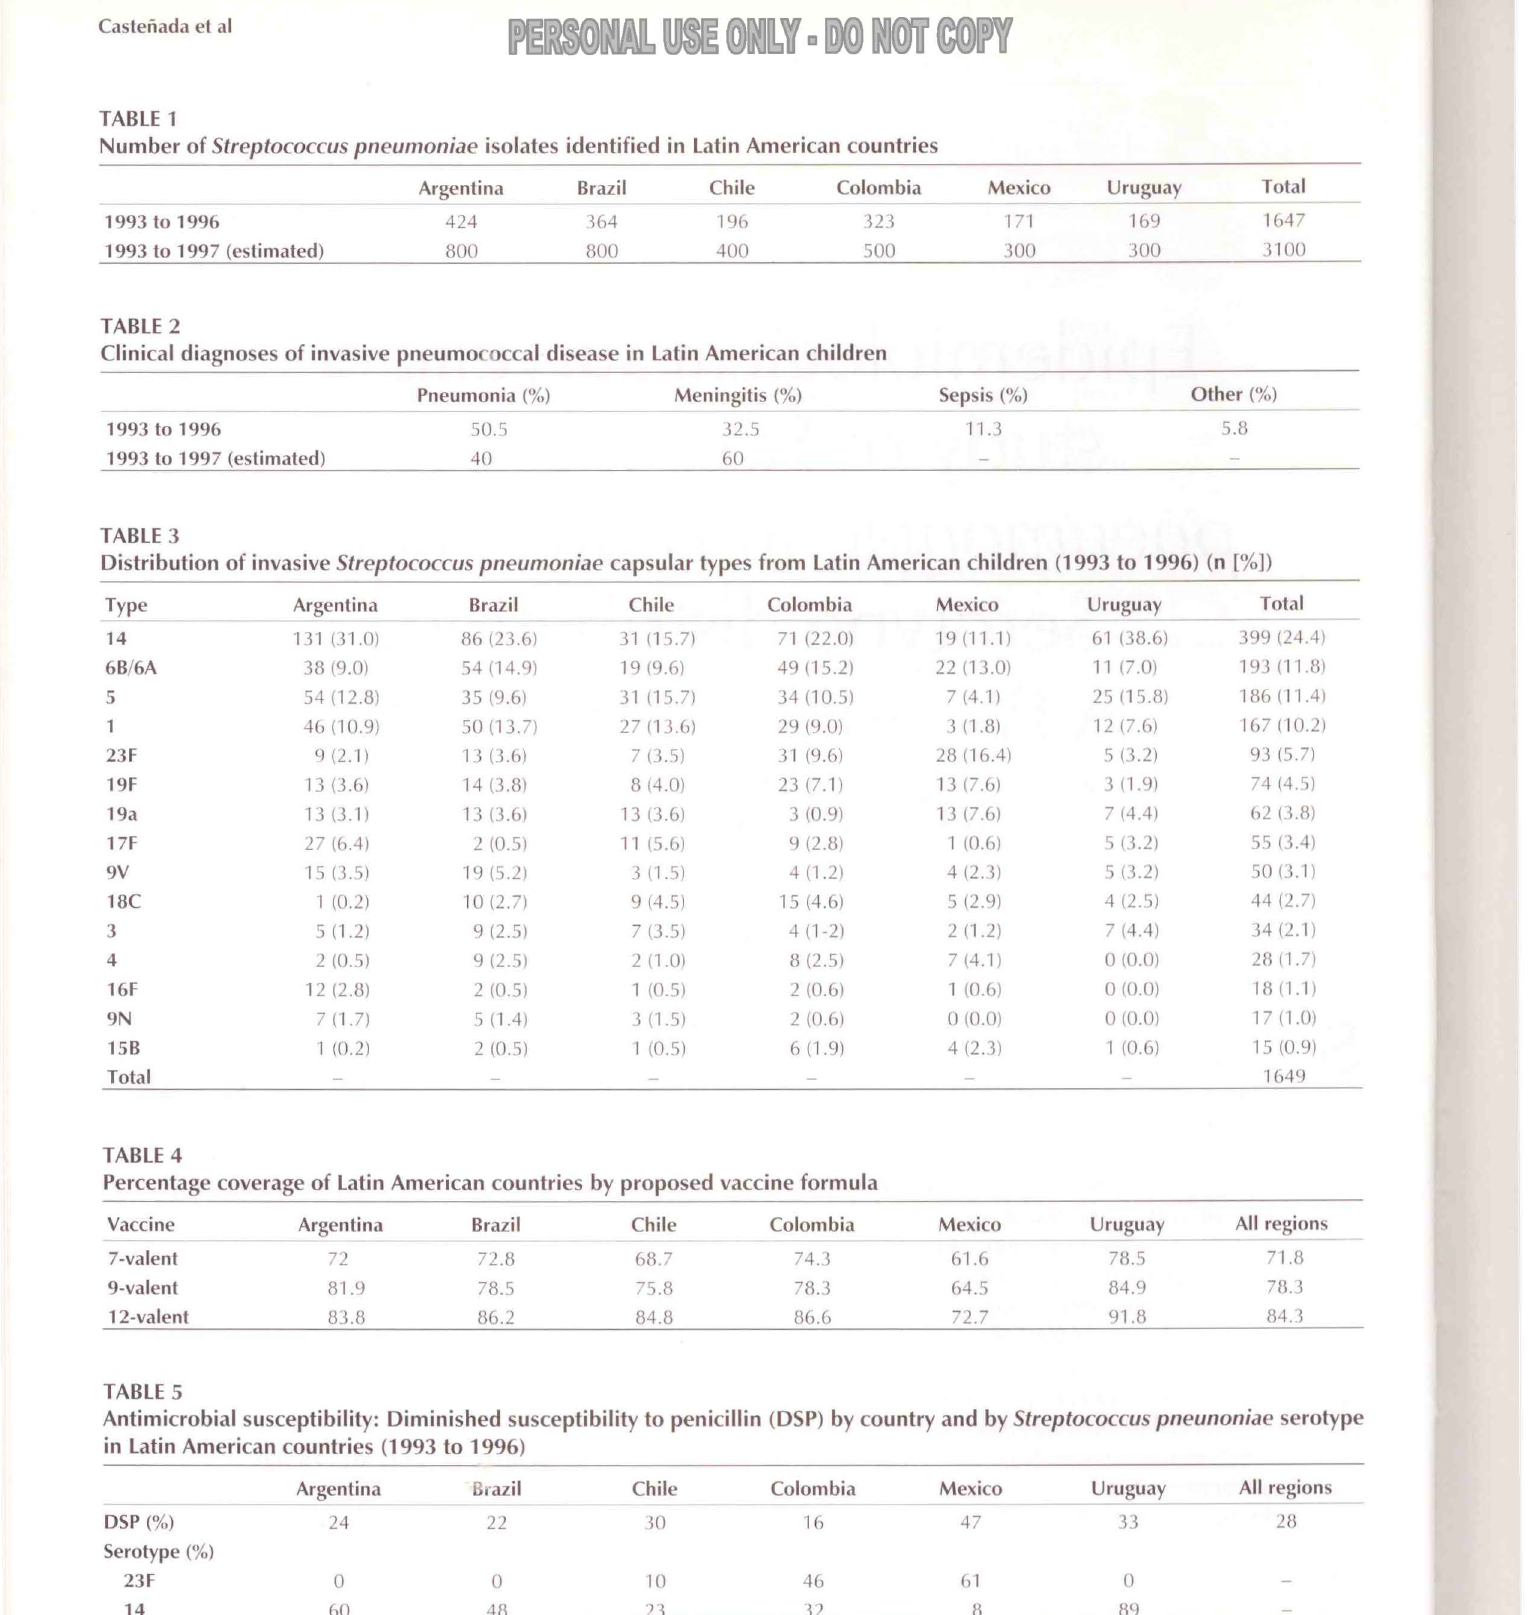
Number of Streptococcus pneumoniae isolates identified in Latin American countries